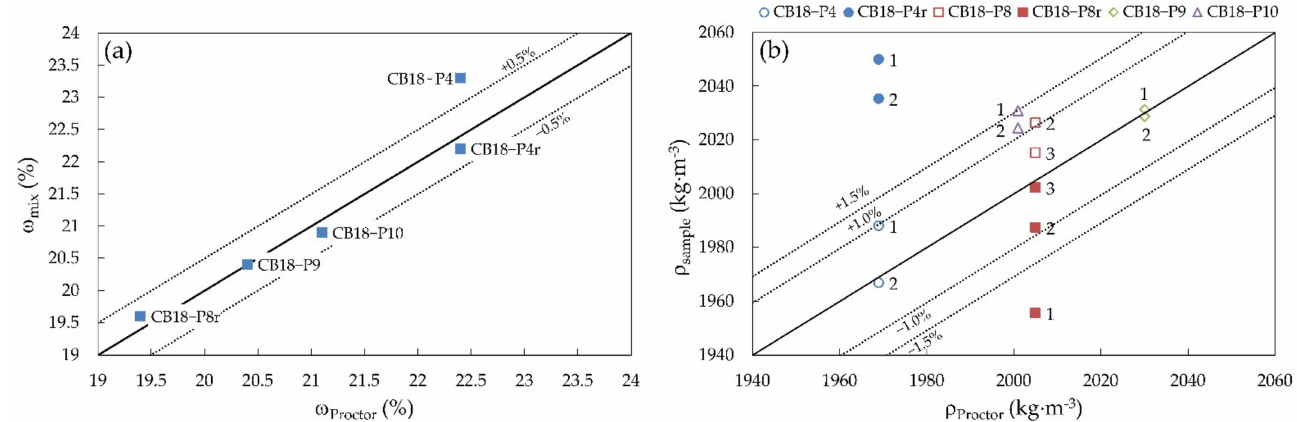
Figure 13. Phase I Simple Compression samples compared to the standard Proctor samples. ( a ) Moisture content of the soil mixtures ( ω mix) prepared for the compaction of the Simple Com- pression Phase I samples versus the target moisture content ( ω Proctor); ( b ) Apparent density of the Simple Compression Phase I samples ( ρ sample) versus the target density ( ρ Proctor); values refer to the number of the